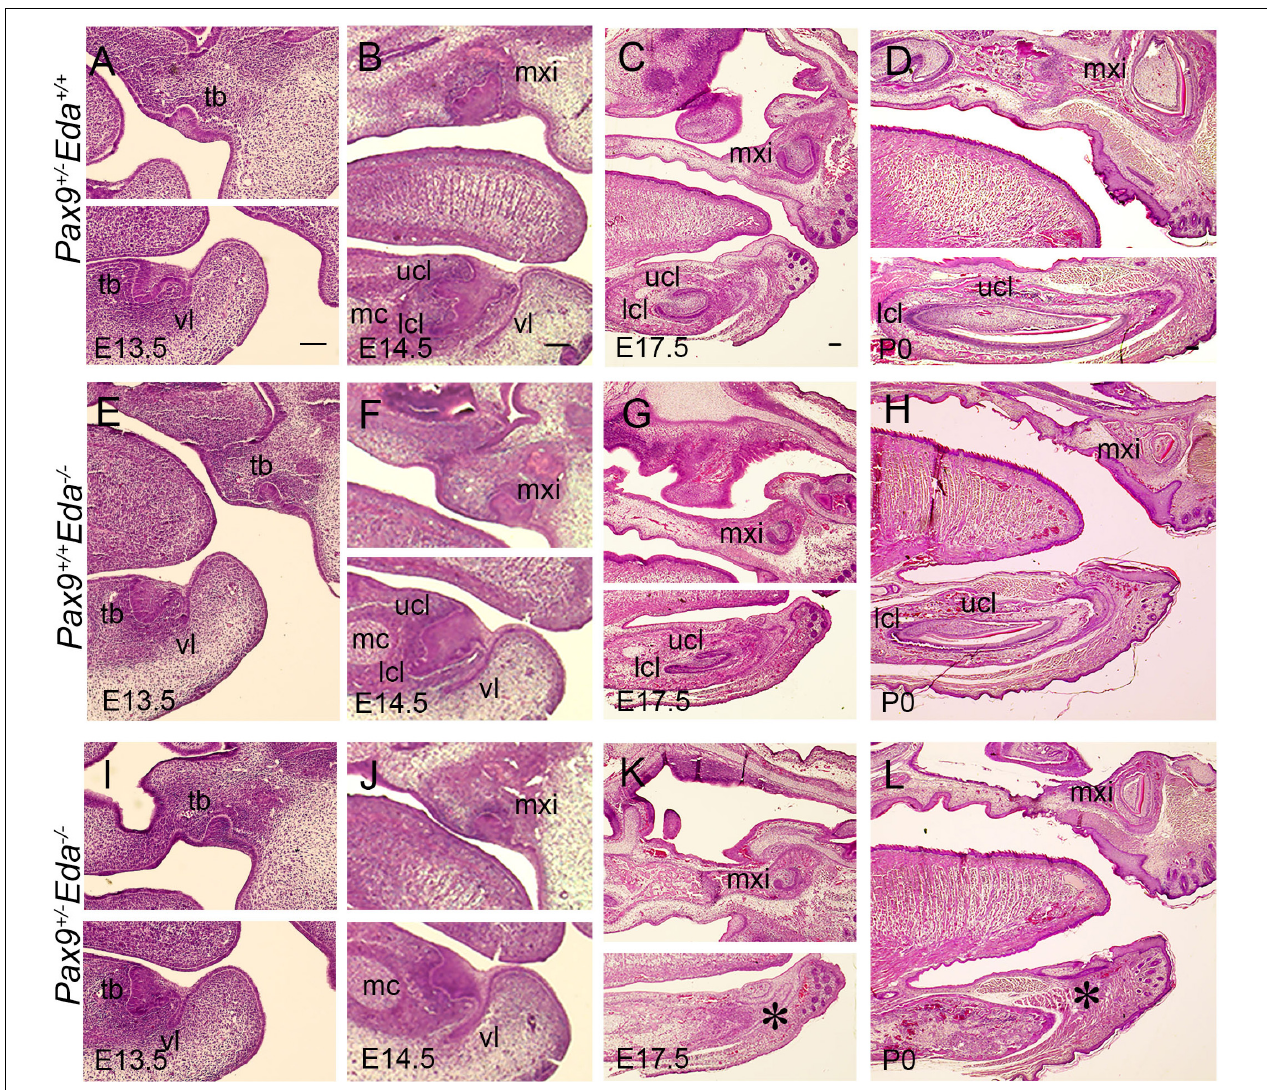
FIGURE 2 | Incisor developmental defects in the Pax9 + / − Eda − / − compound mutant embryos. Hematoxylin and eosin-stained (HE) sagittal sections through the developing incisor tooth germs. The Pax9 + / − Eda + / + , Pax9 + / + Eda − / − , and Pax9 + / − Eda − / − compound mutants at E13.5 (A,E,I) , E14.5 (B,F,J) , E17.5 (C,G,K) , and P0 (D,H,L) , respectively, are shown. Scale bar presented 100 µ m, * indicates the region of missing incisor. lcl, lower cervical loop; mc, Meckel’s cartilage; mxi, maxillary incisor; tb, tooth bud; ucl, upper cervical loop, vl, vestibular